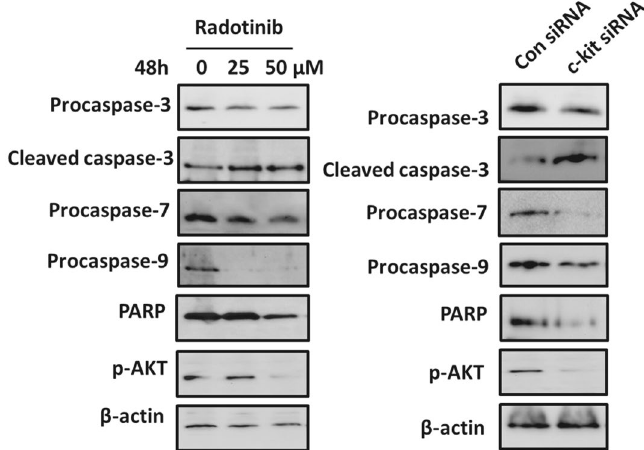
Figure 2. Corrected version of Figure